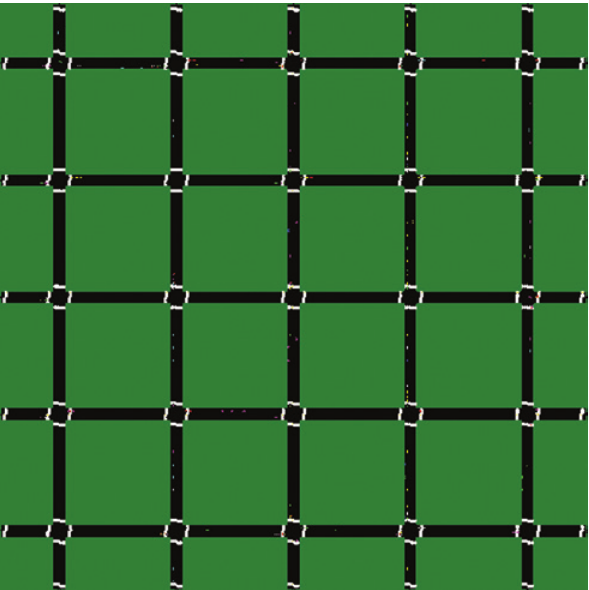
Figure 2: Network Configuration Composed of 25